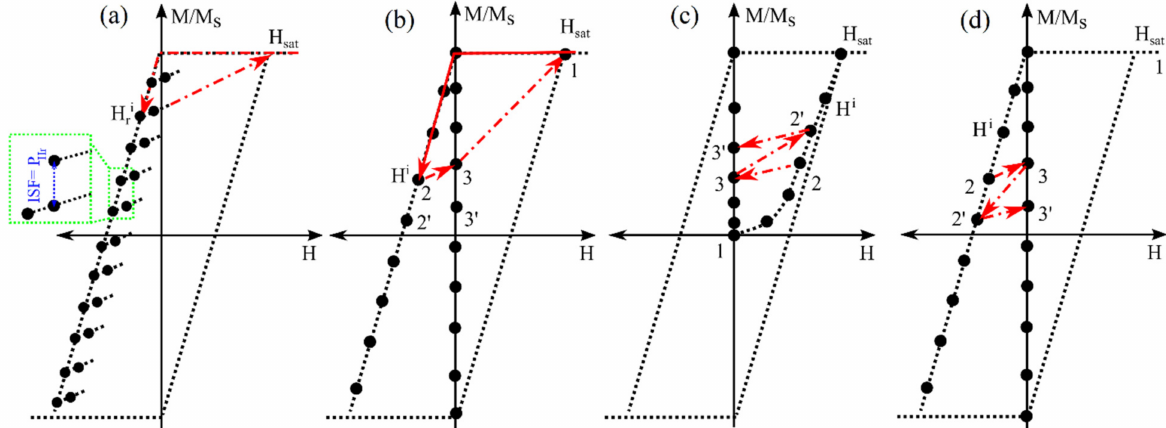
Figure 5. Schematically demonstrating the data collection protocols for ( a ) the projection method, ( b ) backward remanence method, ( c ) isothermal remanence method, and ( d ) DC demagnetization method. The projection method ( a ) provides the irreversible switching (equivalent to the residual magnetization) at the reversal field, Hr. While, the remanence methods ( b – d ) provide the residual magnetization at the zero applied field, H, such as points 3 and 3’. The key feature that separates the backward remanence ( b ) from the isothermal remanence ( c ) and the DC demagnetization remanence ( d ) is the saturating the whole system before applying the Hr and removing